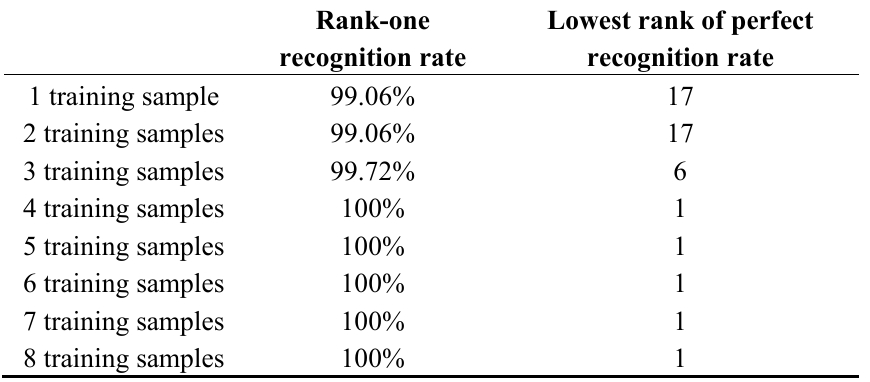
Table 7. Identification performance by different number of training